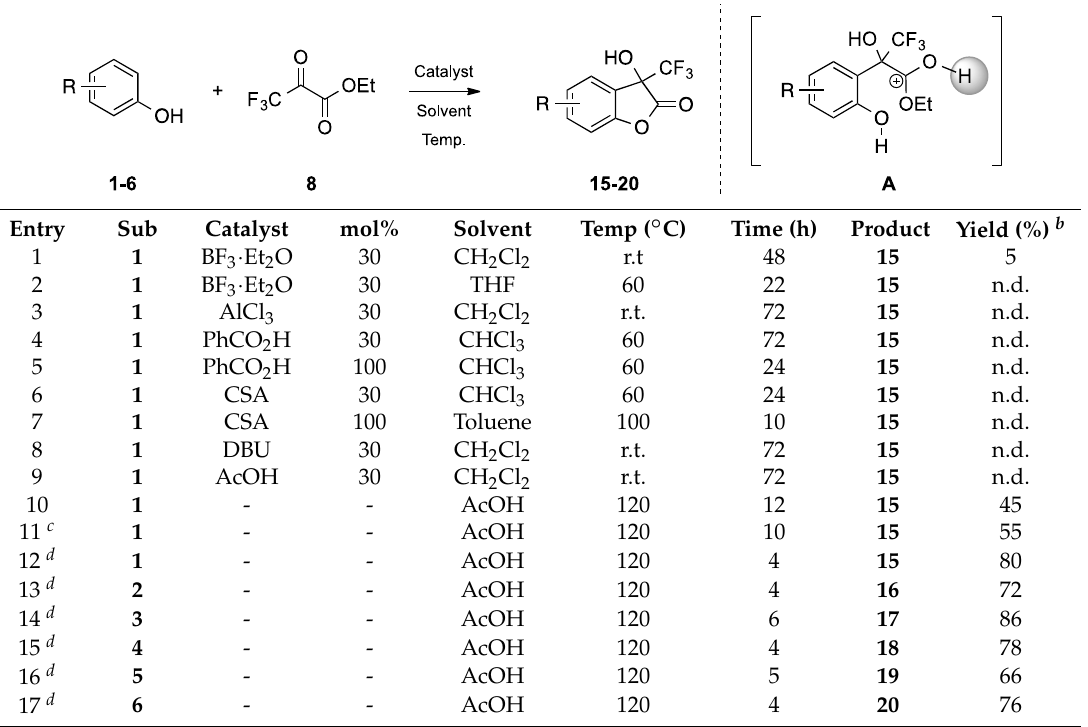
Table 2. Reaction of 3,3,3-trifluoromethyl pyruvate 8 with polyphenols 1–6 a .